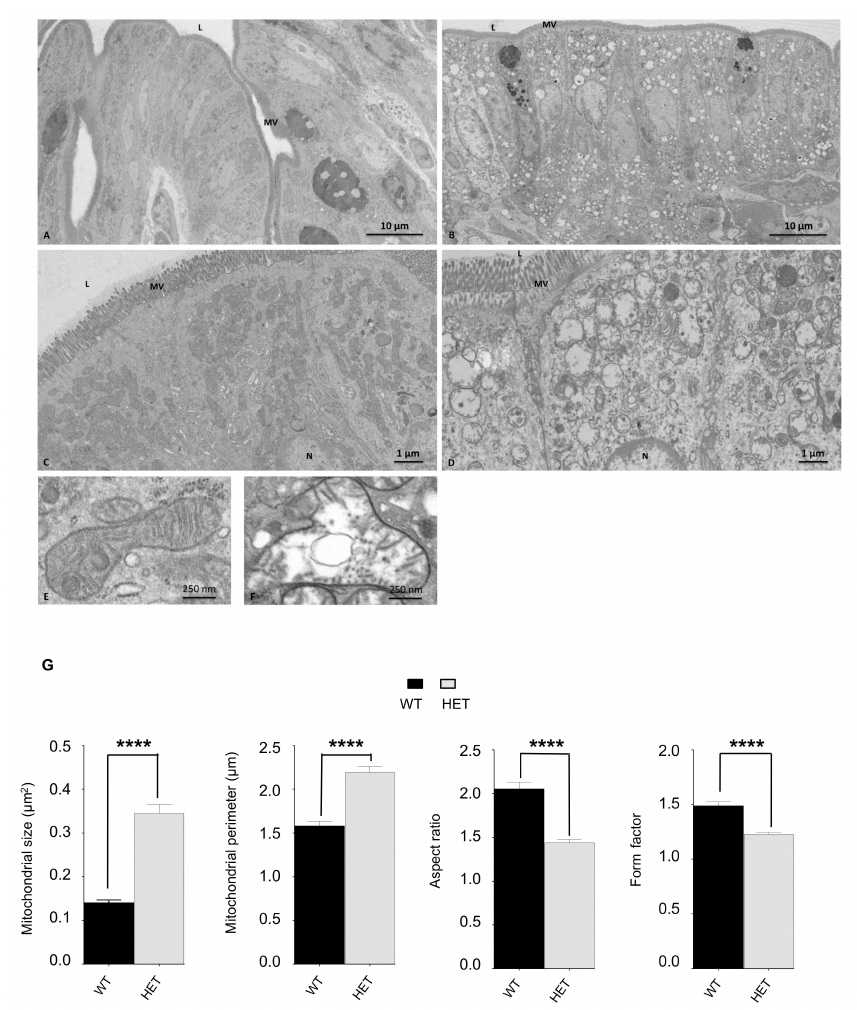
Figure 3. Ultrastructure analysis of mitochondria morphology of colon enterocytes of a wt and het mouse. ( A – F ) Ultrastructural features of mouse colon epithelium. A , C , E : wt; B , D , F : het. L = lumen; MV = microvilli; N = nucleus. ( G ) Analysis of mitochondrial size, perimeter, aspect ratio and form factor. Wt n = 203, het n = 153. Data are expressed as mean ± SEM. *** * p <